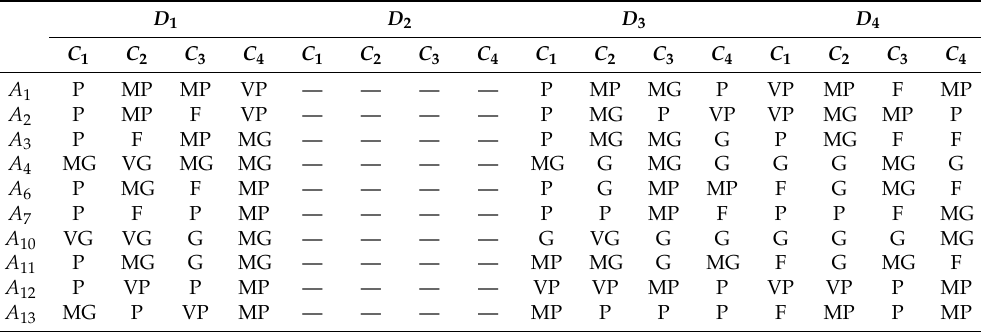
Table 3. The decision-matrix of each decision-maker at second period ( t = 2).